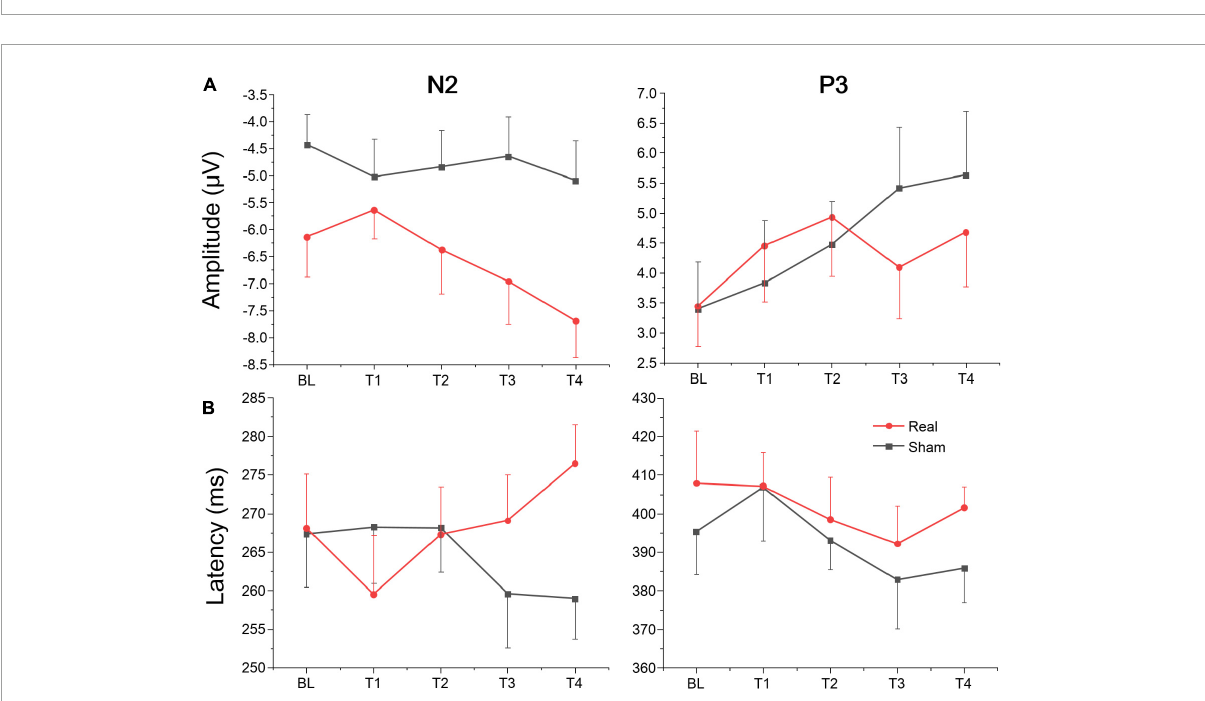
FIGURE7 Amplitude and latency of ERPs component for Go/Nogo task at each time point. (A) Mean amplitudes of N2 and P3. (B) Mean latencies of N2 and